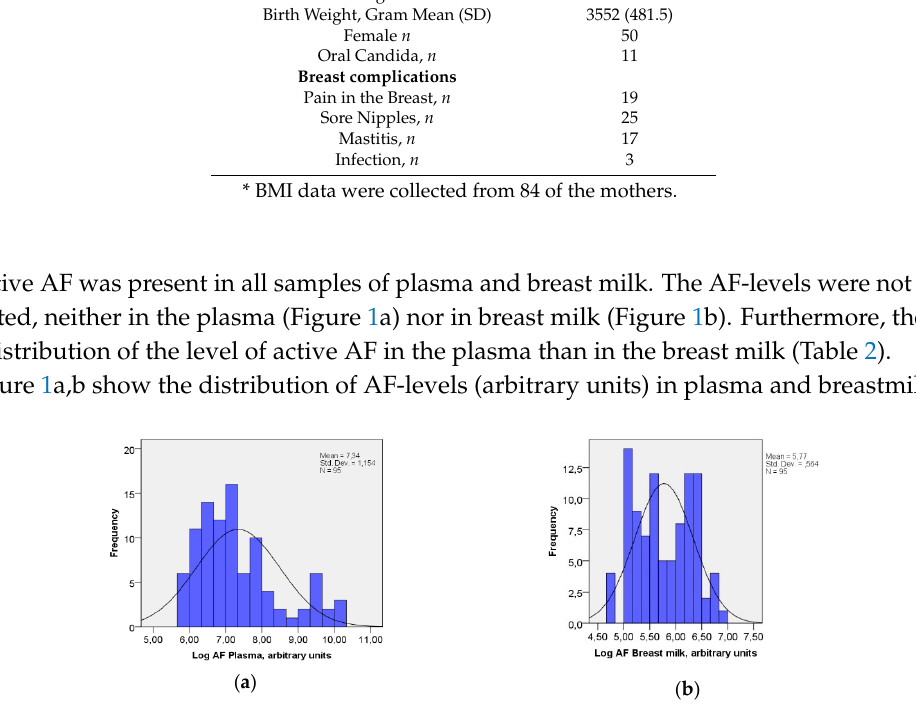
Figure 2. Correlation between the AF-levels (arbitrary units) in plasma and breast milk, Spearman’s rho = 0.403, p < 0.001. We found that there was a positive correlation between AF in plasma and the BMI of the mother (Spearman’s rho 0.252, p < 0.05, Figure 3a), while the correlation to AF in breast milk was not statistically significant (Figure 3b). There were no differences in AF-levels depending on parity, gestational age, or mode of delivery. Figure 3a,b show the AF-levels in plasma and breastmilk in correlation to maternal BMI. None of the mothers reported the intake of specially processed cereals (SPC-Flakes ® ), and we found no relation between AF and the intake of other cereals on the market (i.e., breakfast cereals, grain, porridge). Seventeen mothers reported a history of vaginal fungal infection during pregnancy and 14 of 17 received anti-fungal treatment. No correlation was found between the level of active AF in plasma or breast milk with neither vaginal fungal infection during pregnancy nor treatment. Furthermore, there was no correlation between infant Candida colonization and AF-levels in plasma or breastmilk ( p > 0.05). Twenty-five women reported having had sore nipples. There was a positive correlation between having had sore nipples and pain in the breast (Spearman’s rho 0.387, p < 0.01), inflammatory mastitis (Spearman’s rho 0.443, p < 0.01), and breast infection (Spearman’s rho 0.302, p < 0.01), but no correlation was demonstrated between having had sore nipples or pain in the breast and AF-level in plasma or breast milk.